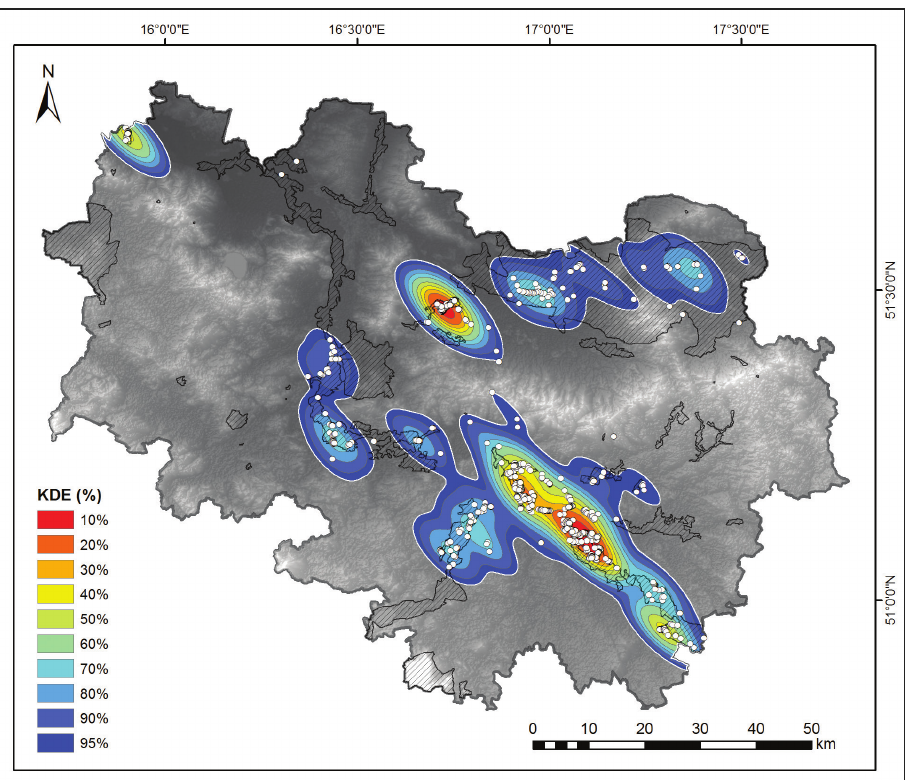
Figure 2. The current distribution of Cerambyx cerdo L., 1758 (n = 1025 locations) in south-western Poland and predicted species range delineated by kernel density estimations (KDE) using plug-in band- width selection. White lines show the border of 95% KDE. The dashed areas represent the network of overall protected areas